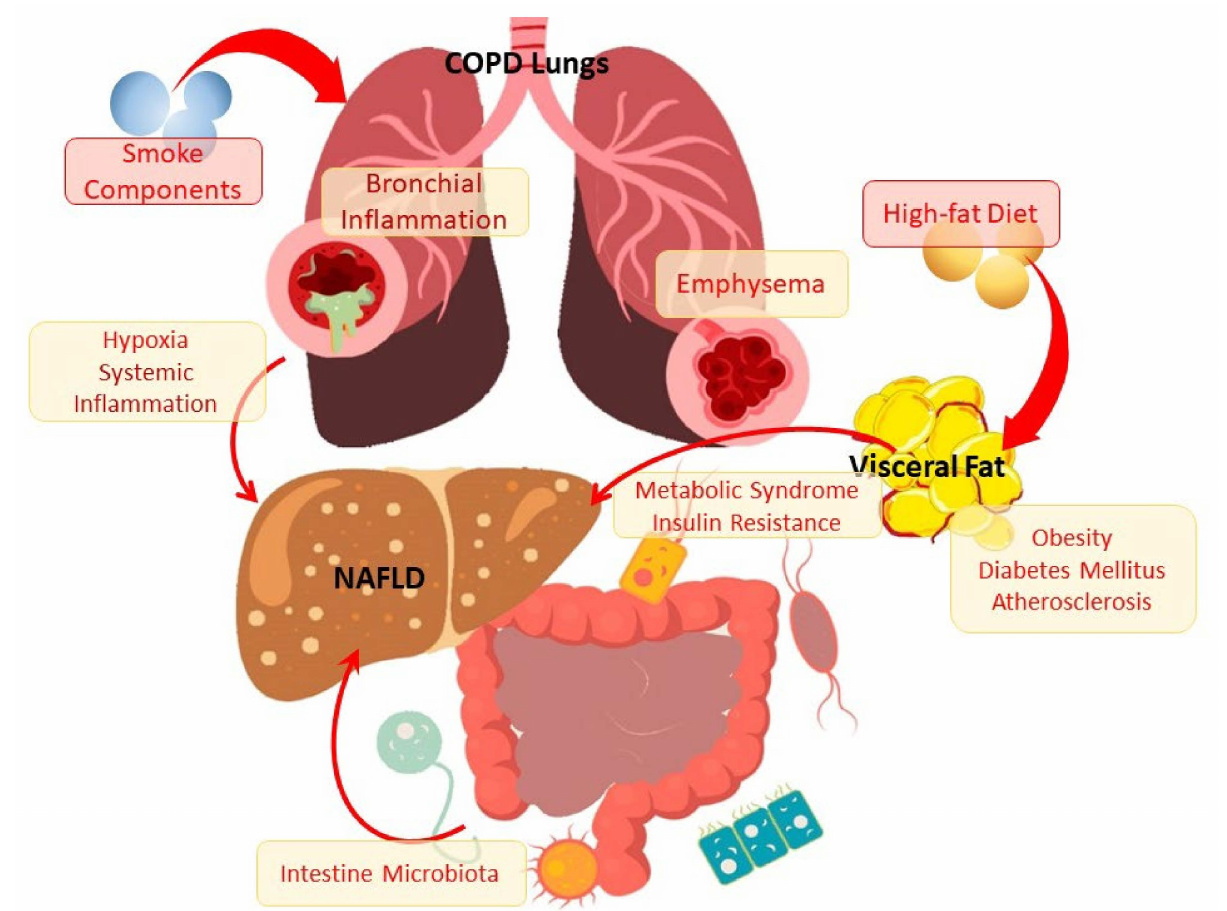
Figure 1. The scheme of the relationship between NAFLD and COPD through metabolic disorders and